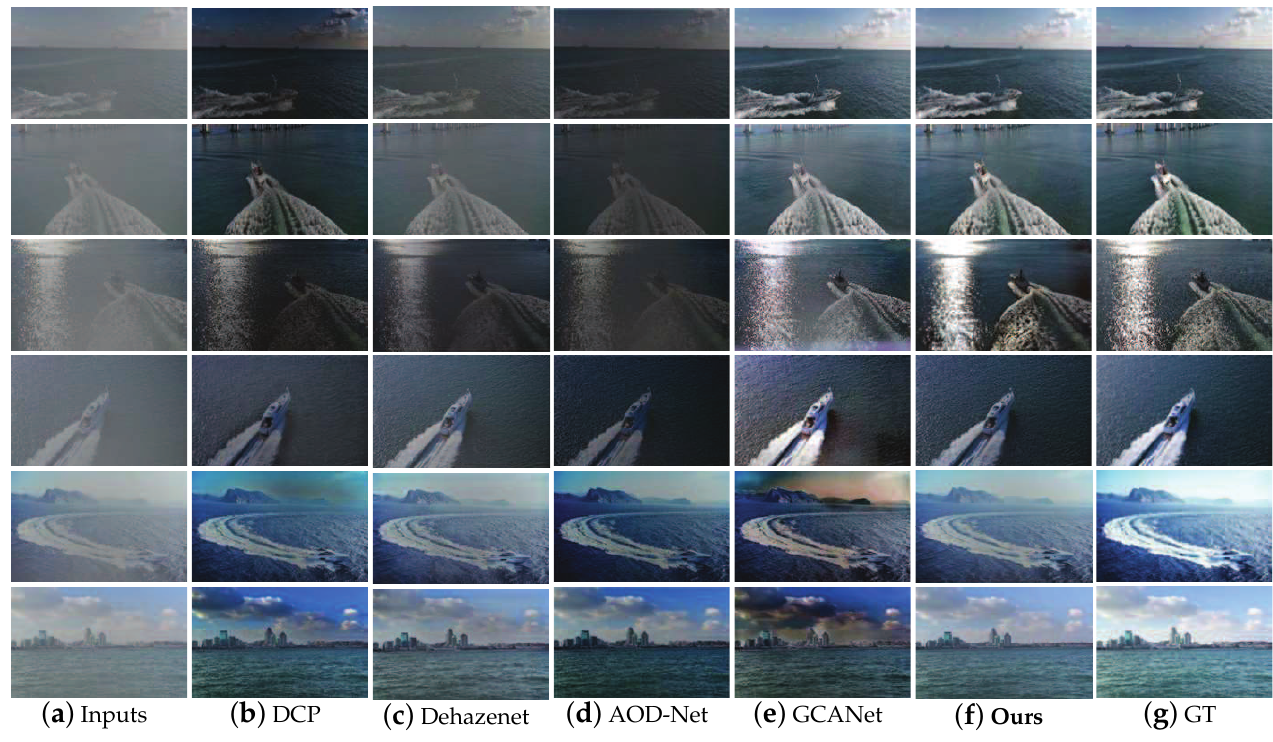
Fig. 7. Qualitative comparison of different dehazing networks in synthetic images(GT: Ground Truth). Figure 7. Qualitative comparison of different dehazing networks in synthetic images (GT: ground and there are color distortions in some regions (the sky region in the sixth image in Fig.7(b)), which 253 eventually affect the visual effect. And since DehazeNet and AOD-Net, two deep learning-based 254